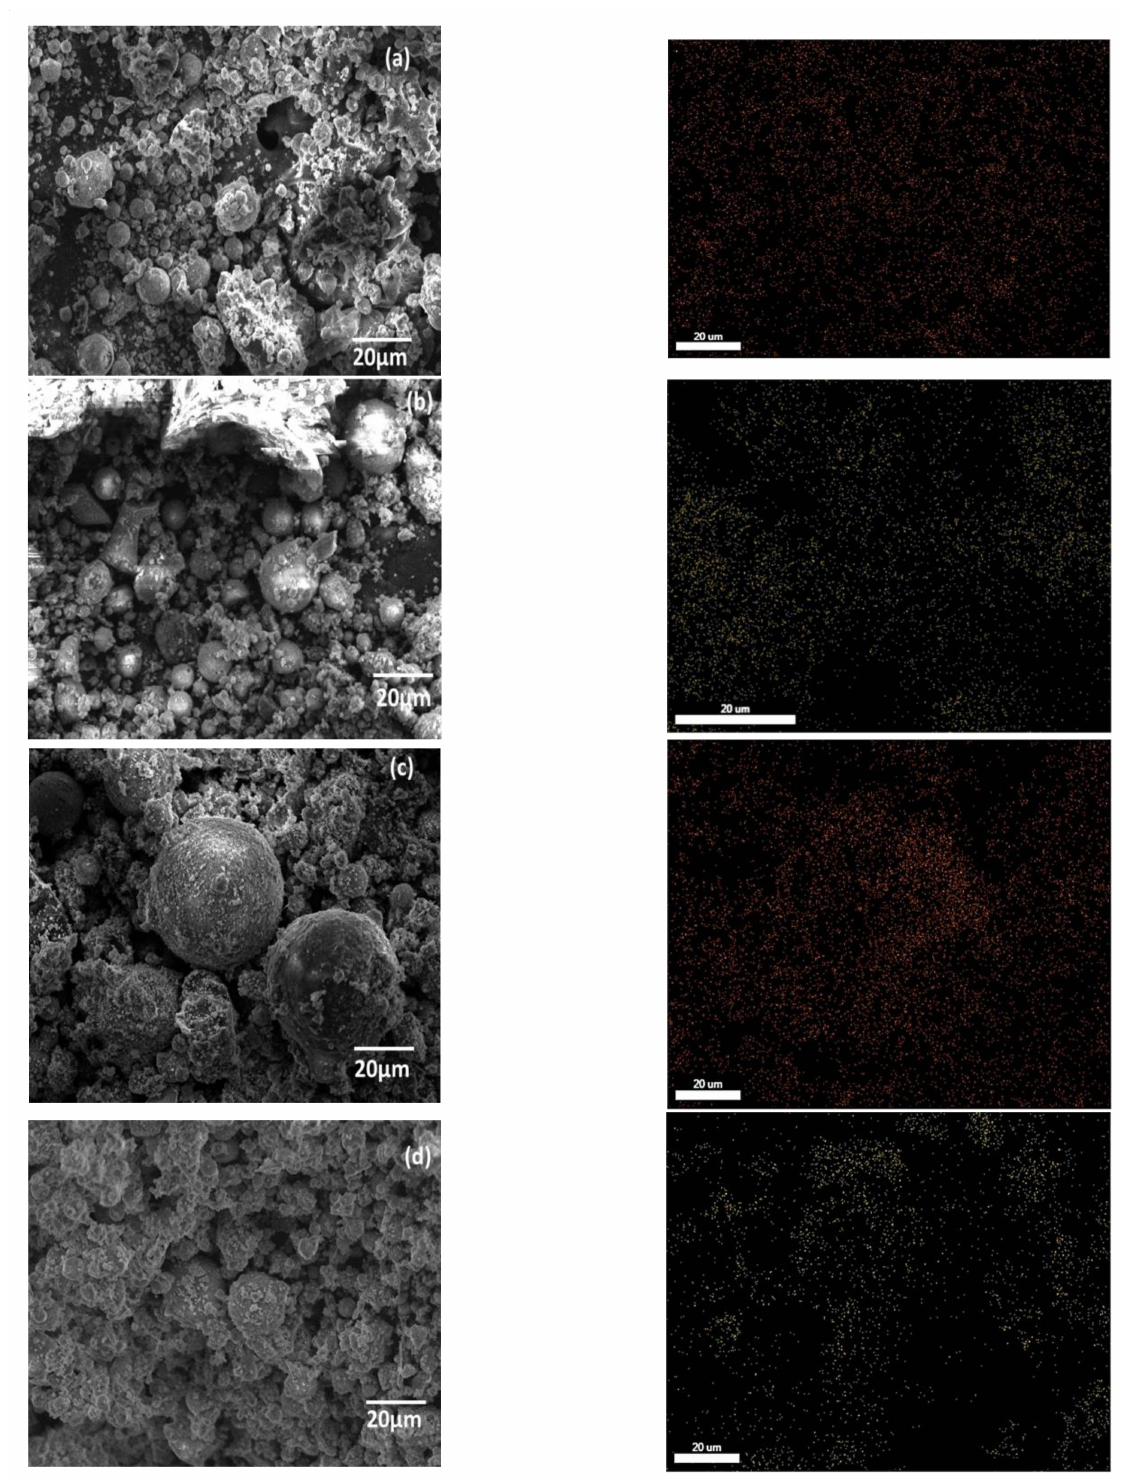
Figure 10. SEM and elemental mapping images: ( a ) Geopolymer after adsorption of Cu 2+ ; ( b ) Geopolymer after adsorption of Cd 2+ ; ( c ) Geopolymer-NanoTiO 2 after adsorption of Cu 2+ ; ( d ) Geopolymer-NanoTiO 2 after adsorption of Cd 2+ . (Experimental conditions: (volume (15 mL), mass of adsorbent (0.3), pH (6.8), ambient temperature, and stirring speed (250